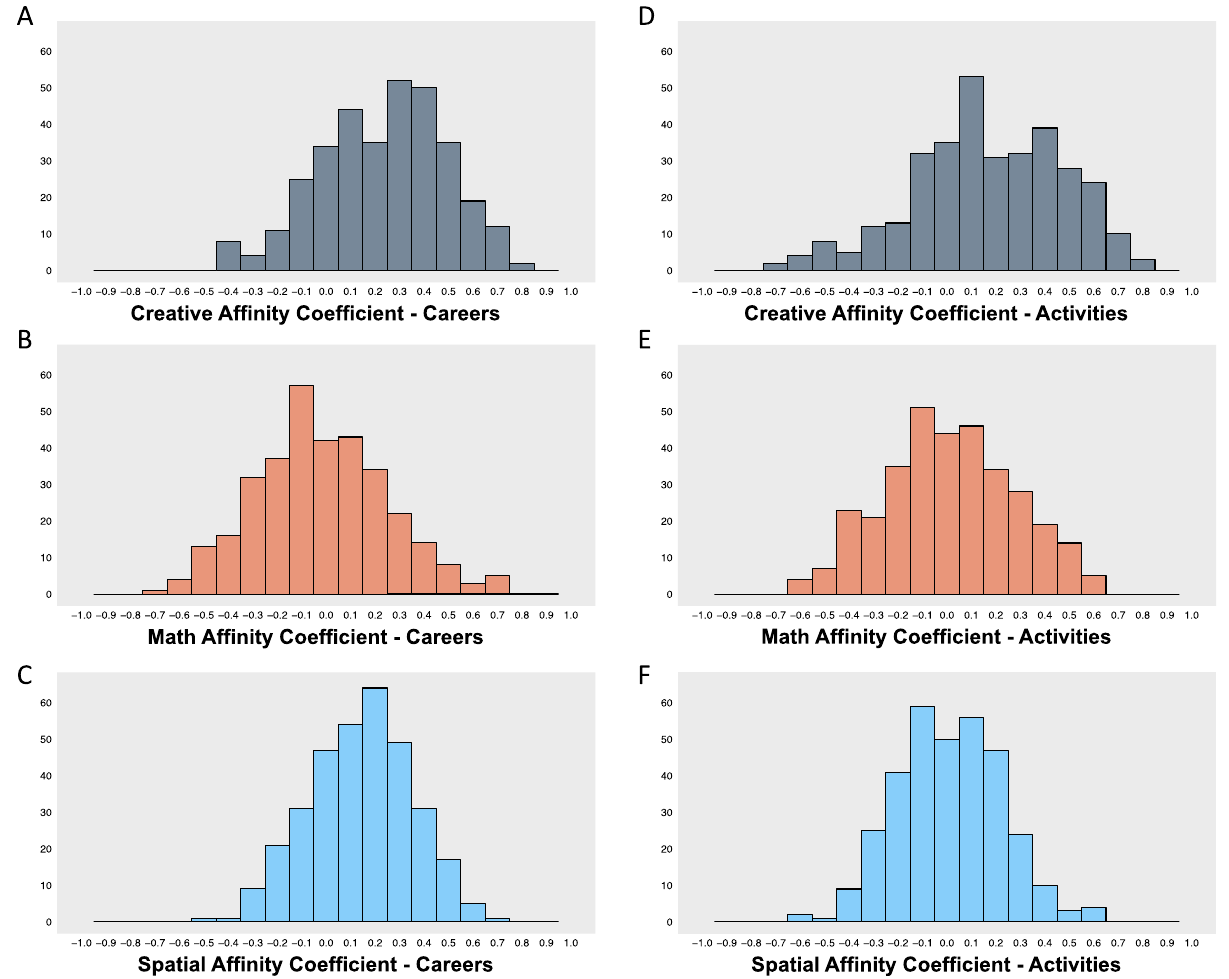
Figure 2. Shows histograms that visualize the distributions of each of the affinity coefficients.